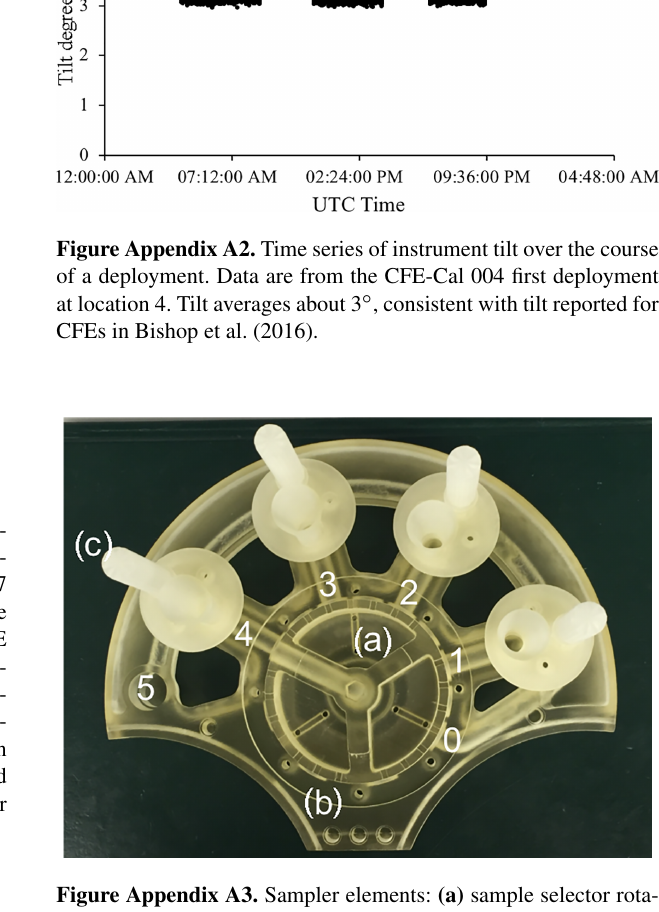
Figure Appendix A3. Sampler elements: (a) sample selector rota- tor; (b) main structural element of the sampler. Flow paths (1–4) direct water and particles into sample bottles or (0) to bypass sam- ple bottles; (c) particle retention system, which bridges inflow chan- nels and common exhaust manifold channel (5). Sample rotator is shown open at position 4. When not sampling, the rotator is sealed to closed